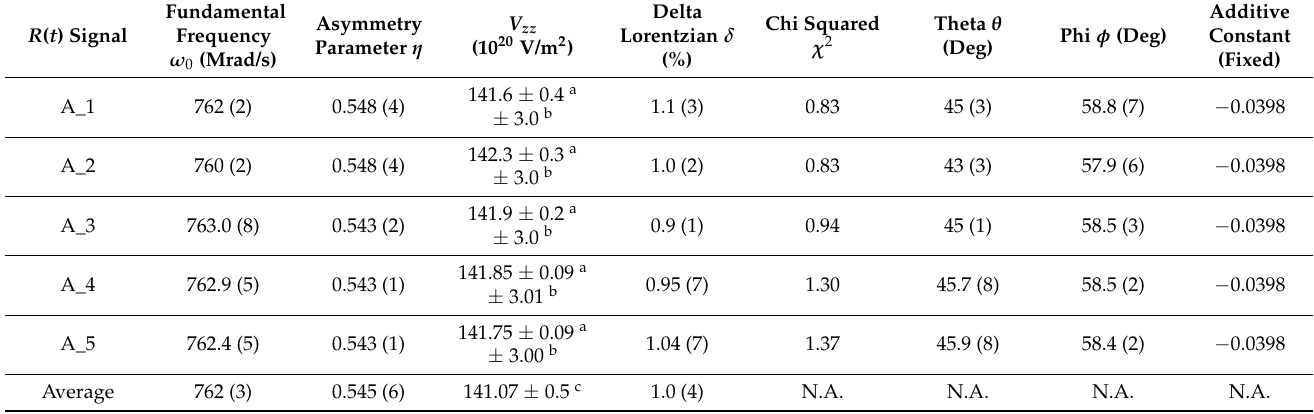
Table A2. Table of fitted hyperfine and experimental parameters for this set of 5 different e − γ TDPAC measurements of 181 Ta(TiO 2 ), returned by the Gfit19 TM program. It is noted that this set contains e − γ TDPAC signals corresponding to the case where our 181 Hf-implanted single crystal TiO 2 was subjected to 30-min annealing at a temperature of 873 K in a vacuum (Termed “A_”). For the individual values of V zz , the fit uncertainty is separated into (a) the statistical uncertainty caused by our instruments, and (b) the (dominant) systematic uncertainty of the quadrupole moment ( ± 2.1%) as quoted in reference [51]. The multiplicative constant and additive constant of this set of e − γ TDPAC measurements is fixed at 1 and − 0.0398, respectively. The averaged values of ω 0 , η , and V zz from this set of e − γ TDPAC measurements were calculated, with (in the case of V zz , (c)) the uncertainty assigned the square root of the sum of squares of their statistical uncertainty (in the case of V zz ,